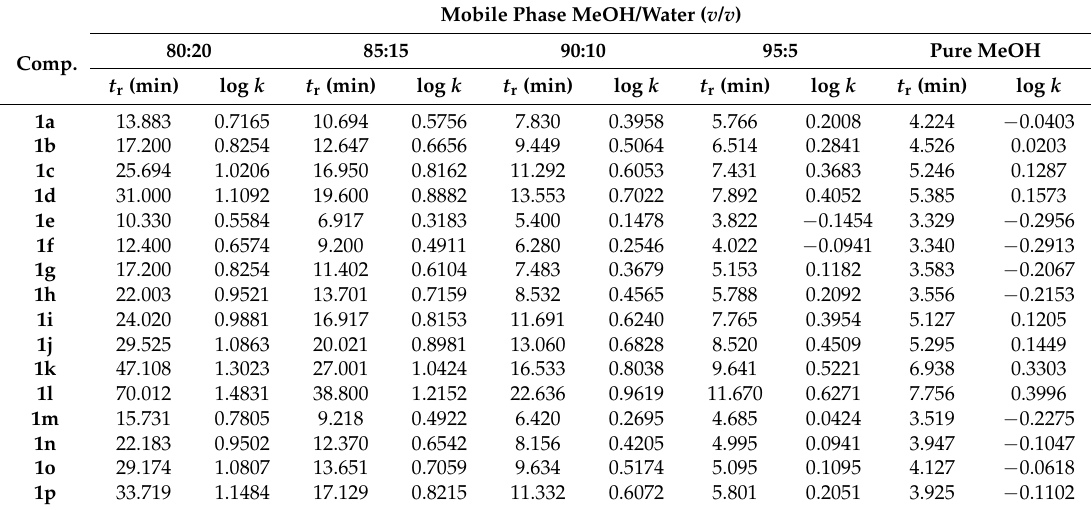
Table 2. Retention times t r (RP-HPLC) and lipophilicity indices log k (RP-HPLC) of the compounds 1a – p estimated in the mobile phases with a various volume ratio ( v / v ) of a methanol (MeOH) organic modifier and